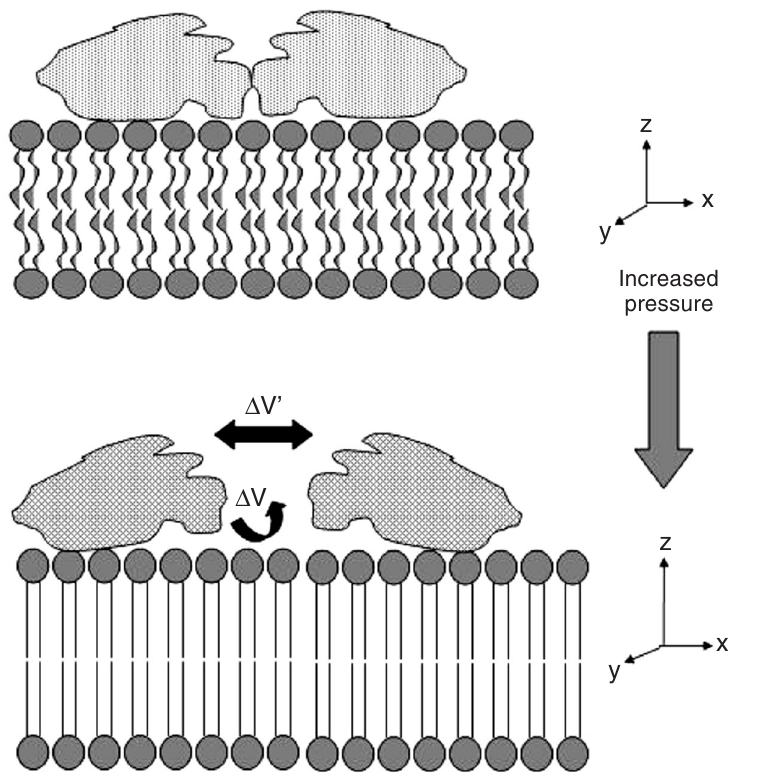
Figure 1. Summary of pressure effects on a membrane-bound protein dimer. The applica- tion of pressure on a membrane-bound protein dimer may result in dimer dissociation due to the permeation of solvent into the packing voids in the dimer interface. This dissociation, given by ∆ V’, should be governed by the same constraints as water-soluble proteins. Increased pressure also compresses the lipid membrane preferentially in the planes perpendicular to the head groups resulting in a lengthening of the bilayer under pressure. However, compression is not expected to greatly perturb the properties of the membrane surface as detailed in the text. Pressure is also expected to promote dissociation of proteins from membranes depending on the size and extent of packing voids between the protein- membrane interface, giving a negative ∆